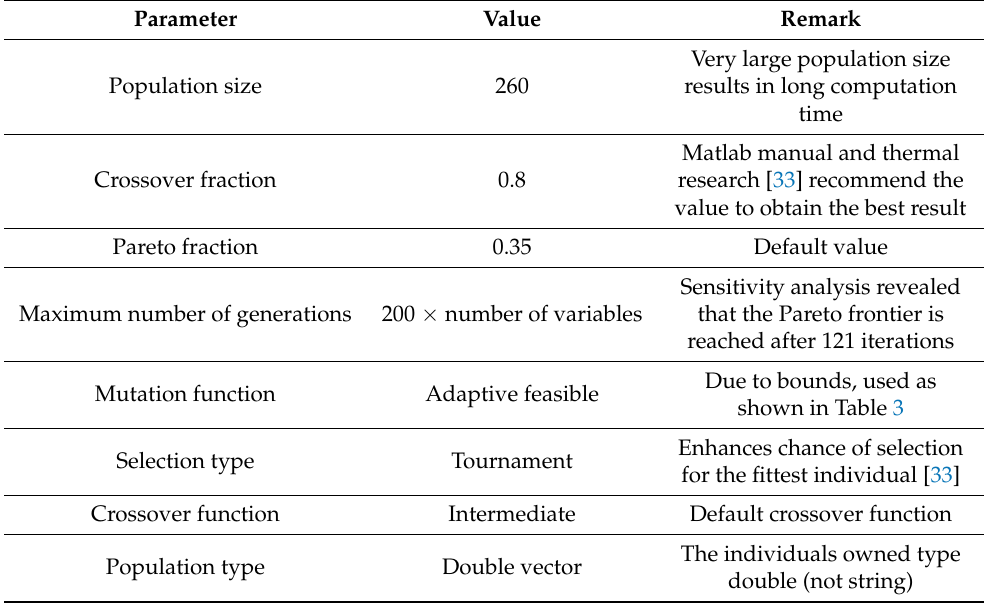
Table 4. Parameters of the multi-objective optimization genetic